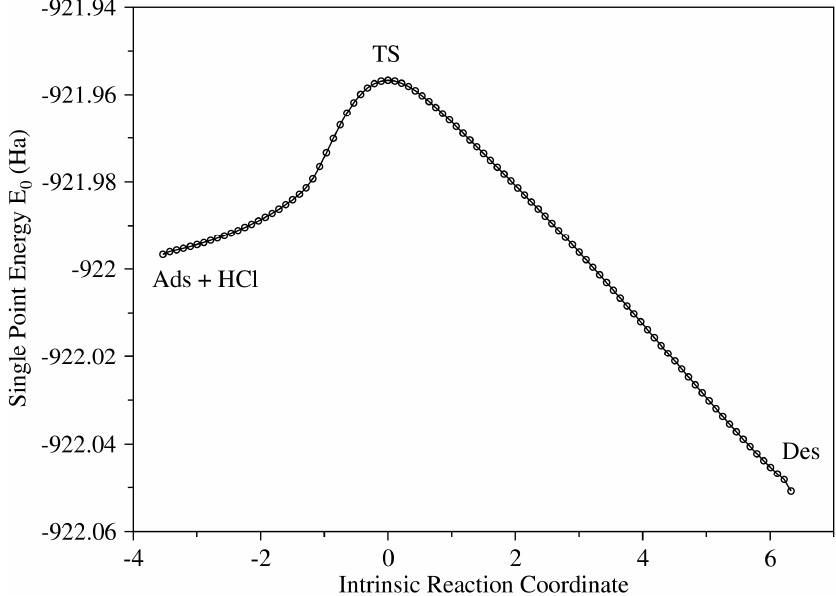
Figure 13. Energy curve from the IRC scan of the TS state in Figure 12, calculated using Gaussian 16. Starting from the saddle point of the TS state, the forward and backward scan lead to the Des and Ads (plus HCl) states, respectively. The forward reaction has a lower energy barrier.